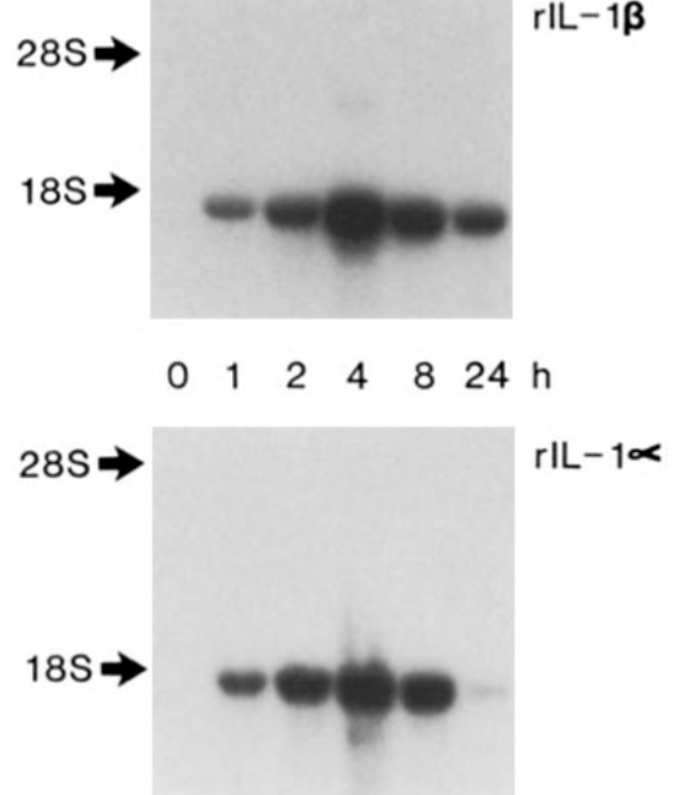
Figure 4. Autoinduction of IL-1 amplifies inflammatory signaling. IL-1 induces IL-1 gene expression. Either recombinant IL-1 β (top) or recombinant IL-1 α (bottom) induced the messenger RNA encoding IL-1 β . Messenger RNA as shown by Northern blotting. Either isoform of IL-1 induced the biological activity as well (not shown.) The concentration of IL-1 β was 100 ng/mL and IL-1 α was 10 ng/mL. From J Exp Med 165:1316-1331; 1987.